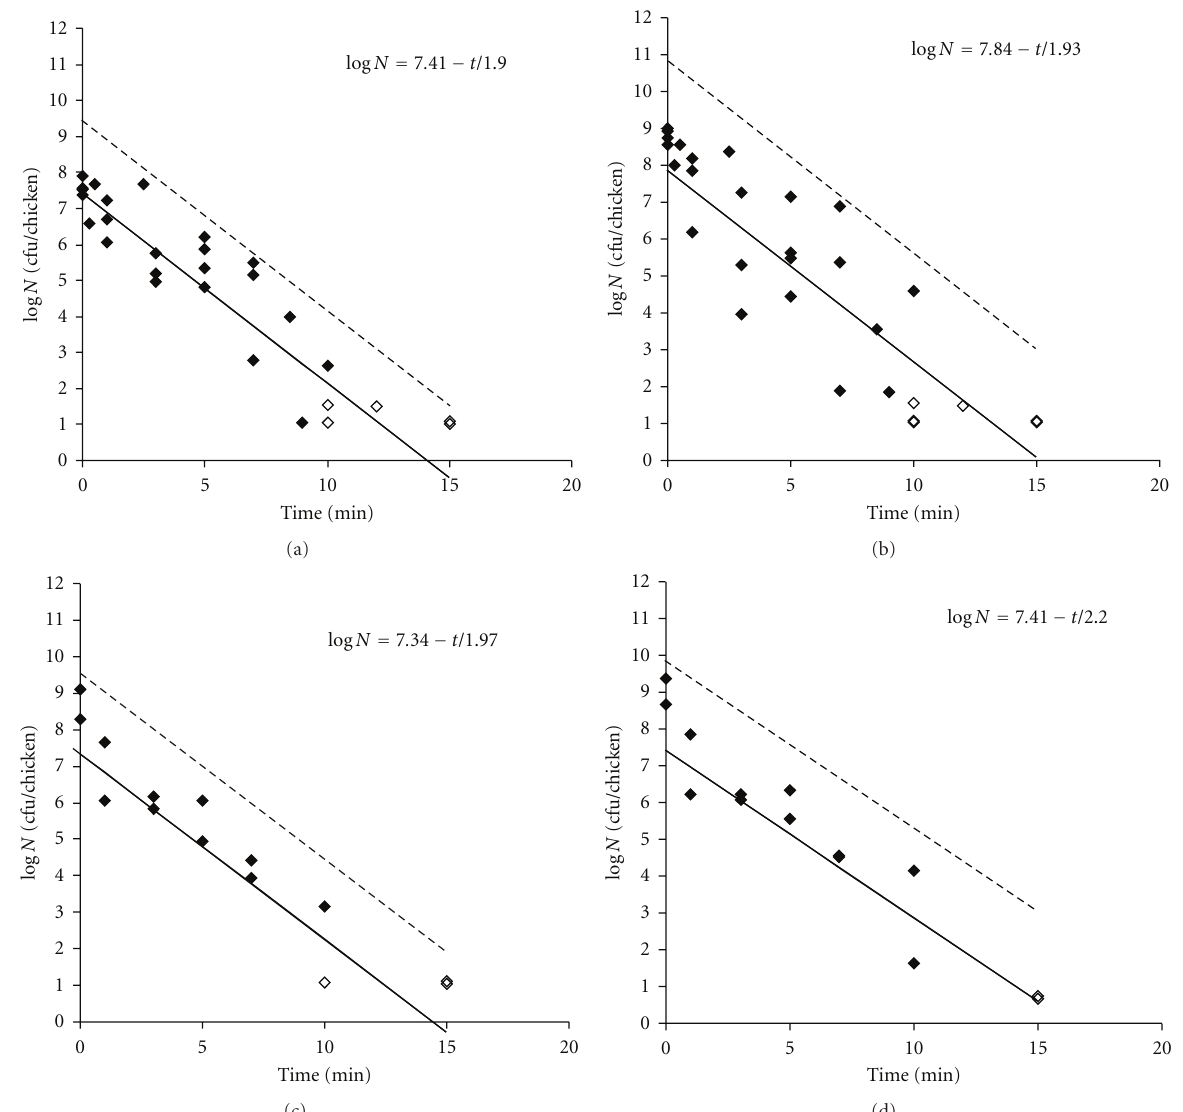
Figure 1: Survival of (a) C. jejuni , (b) L. casei , (c) E. coli , and (d) S. typhimurium DT104 on whole chicken breast fillets during cooking in boiling water. Straight black line: predicted model; grey line: 95% upper confidence limit; open symbols: count below detection